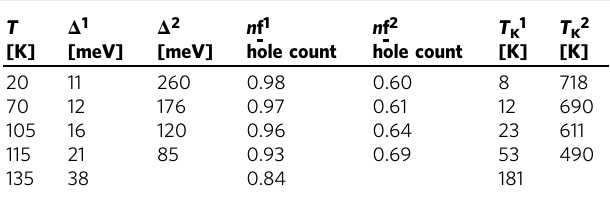
Table I shows list of obtained hybridization values Δ 1 and Δ 2 , the calculated number of Yb holes n f 1 and n f 2 , and the estimated Kondo temperatures T K 1 and T K 2 for the Yb 1 -site and Yb 2 -site, respectively, as a function of temperature in the CDW tetragonal T ʹ -phase. The last row shows corresponding values for the single Yb site in the high- T cubic phase, i.e., the values for Yb 1 -site arethesameasforYb 2 -site.Theerrorbar(SE)fortheholecounts n f 1 and n f 2 is + / – 0.01.Using hole counts and the T K scaling law, we calculate an error bar of + / – 5K for T K = 8K, i.e., T K = 8K + / – 5K. Similarly, since the scaling is a power law, the error bar systematically increases with T K and the largest T K has an error bar of T K = 718K + / –